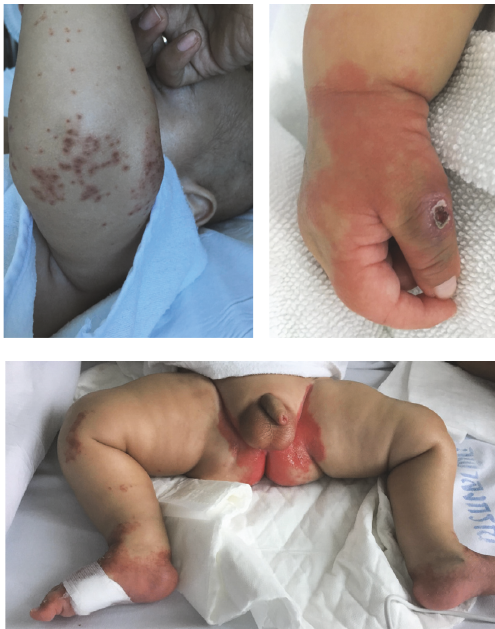
Figure 3: Skin lesions on the extremities and perianal region seen in an MSUD patient with zinc deficiency.